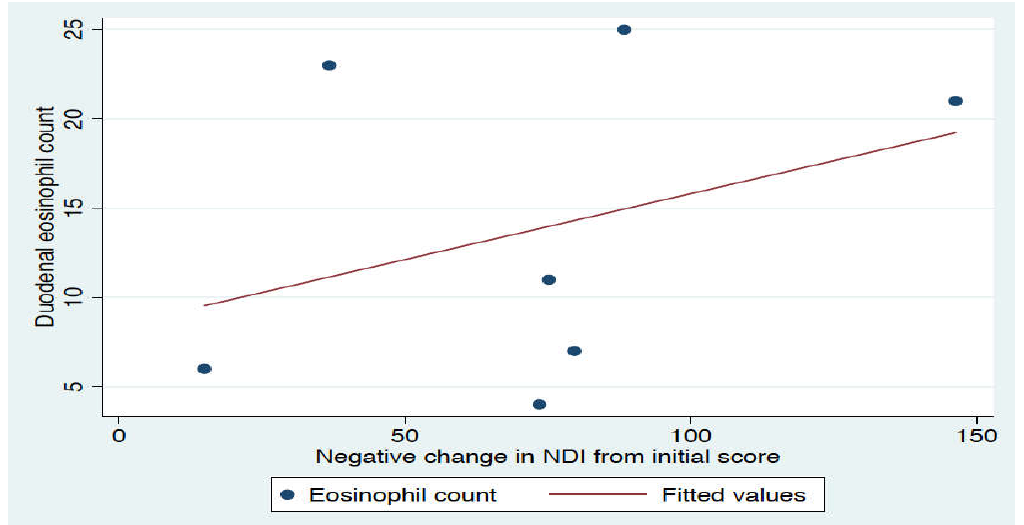
Figure 5. Relationship between duodenal eosinophil count and magnitude of change in the severity of dyspeptic symptoms measured with the Nepean Dyspepsia Index (NDI) after the run-in diet ( p = 0.45, r 2 = 0.12). Duodenal eosinophil count expressed per mm 2 . Four subjects qualified for the rechallenge phase, based on a >30% reduction in their NDI score. Three out of four of these participants completed the protocol. Meaningful analysis of the data was not possible, however there was no signal that one bar caused symptom worsening compared to other bars.